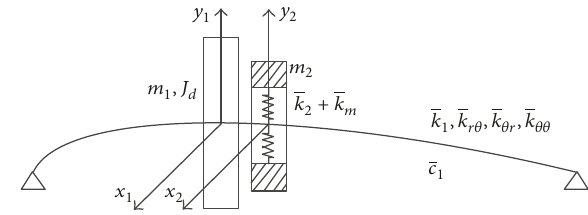
Figure 4: Dynamic model of the rotor-NES